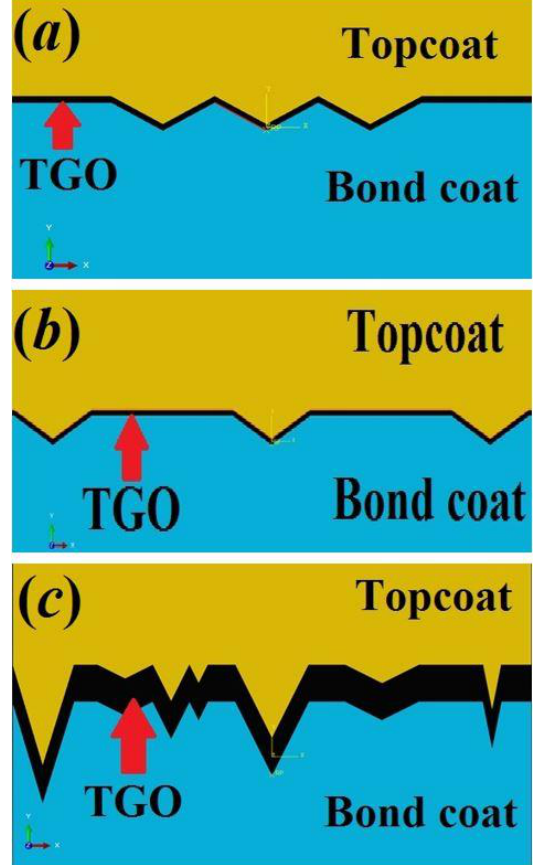
27 of 42 Figure 29. Schematic diagram describing the relationship between tortuosity and width of interfa- cial roughness imperfection for multiple imperfections. The total tortuosity might be identical for both of interfacial roughness profile characterized by ( a ) lower individual tortuosity with wider width, ( b ) higher individual tortuosity with narrower width. However, it is obvious that the width of an individual imperfection is not the same in the roughness profile of Figure 29b as the one in Figure 29a. This indicates that Equation (18), which is used to estimate the width of the bottom side for interfacial roughness for connected imperfections, is not able to describe the roughness profile when there is the